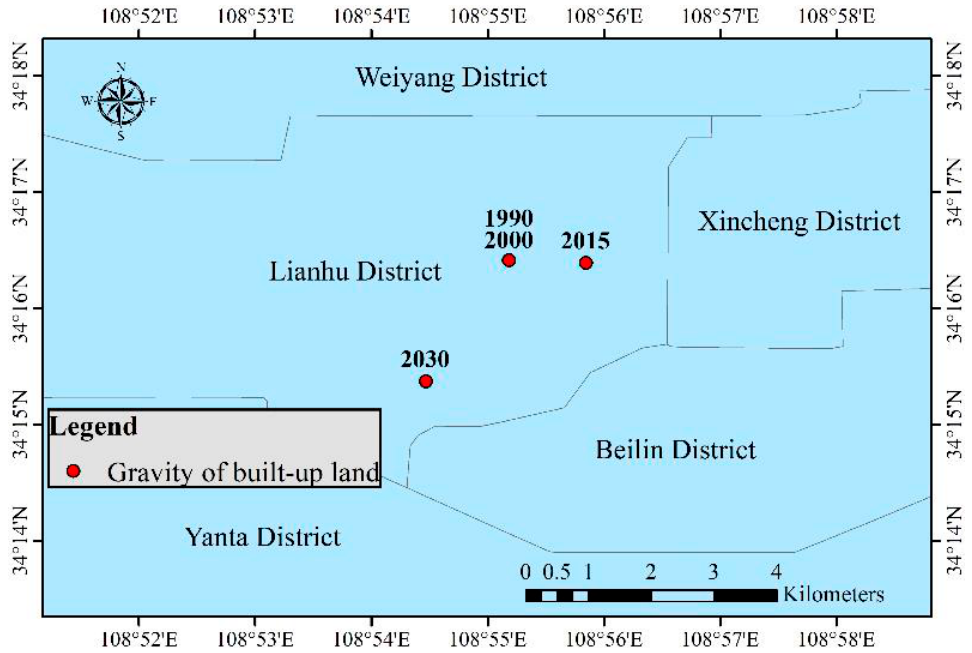
Figure 7. Movement of the built-up land gravity center during two periods.